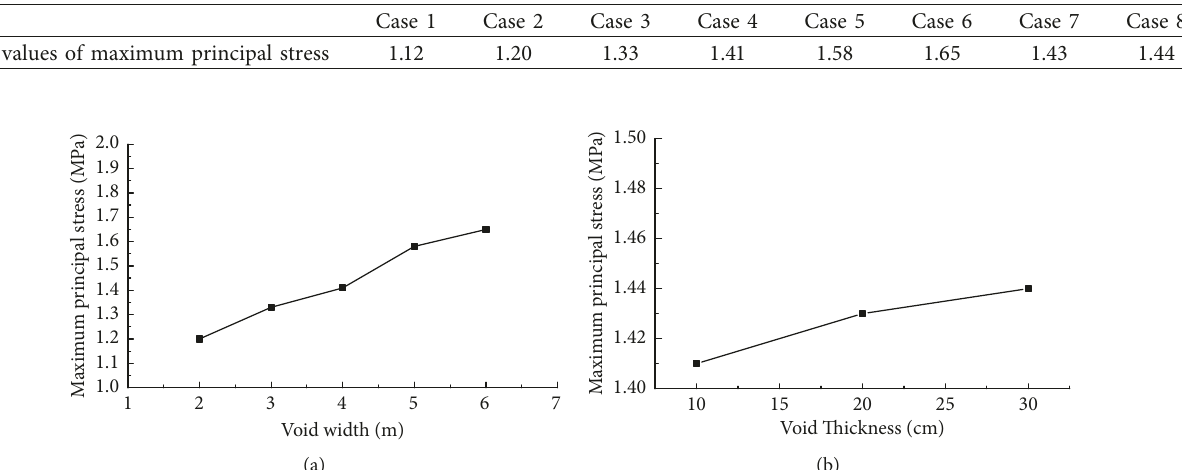
Table 6: Peak values of maximum principal stress of the inverted arch (MPa).